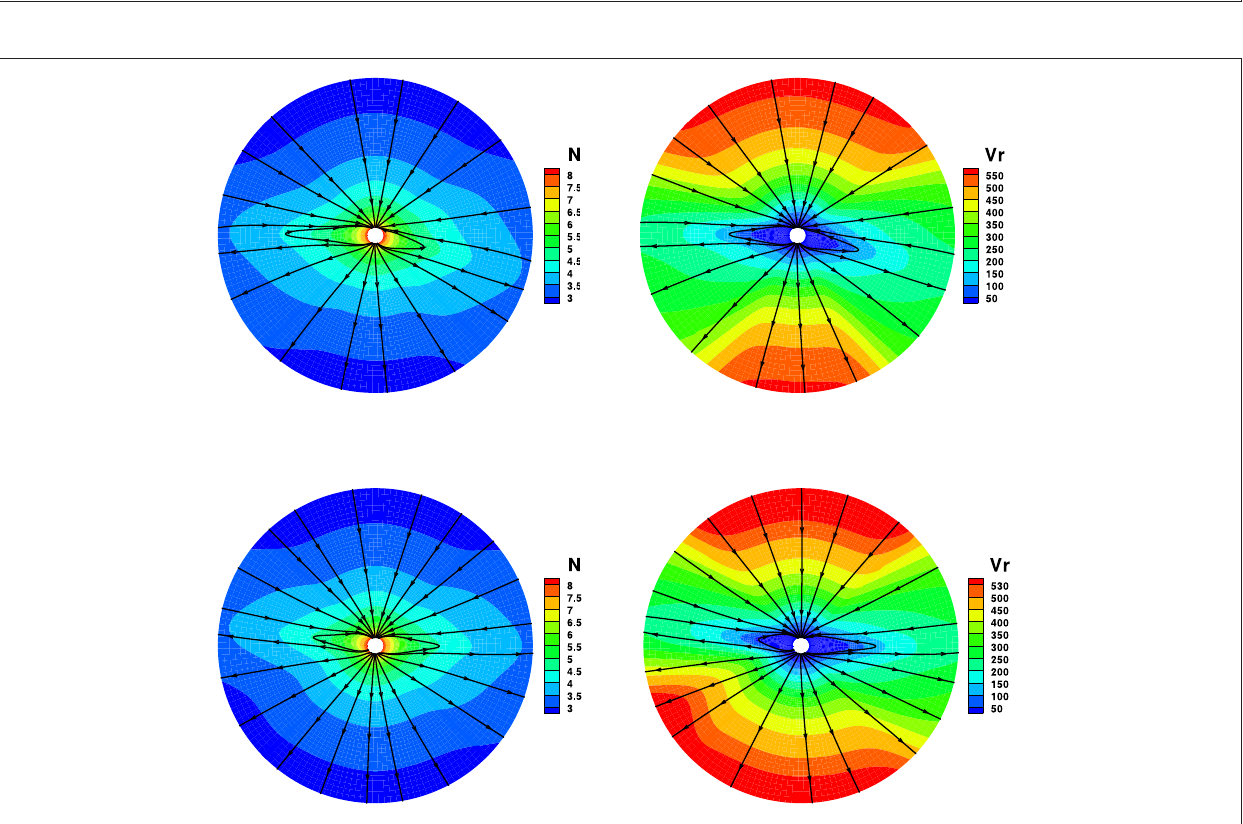
FIGURE 2 | The model results with CT divergence cleaning method, the magnetic field lines, radial speed v r (km/s), and number density N ( log 10 / cm 3 ) on the meridional plane of φ = 180 ◦ − 0 ◦ (top) and φ = 270 ◦ − 90 ◦ (bottom) from 1 to 20 R s